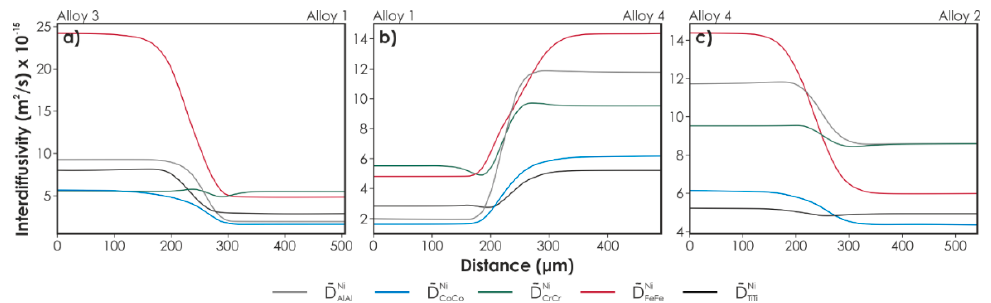
Figure 15. Main interdiffusivities evaluated by HitDIC software along the diffusion paths of the diffusion multiple (after [38]). Reprinted from Journal of Alloys and Compounds 791 (2019), On diffusion behaviors in face centered cubic phase of Al-Co-Cr-Fe-Ni-Ti high-entropy superalloys, 255–264, Copyright 2019, with permission from Elsevier.